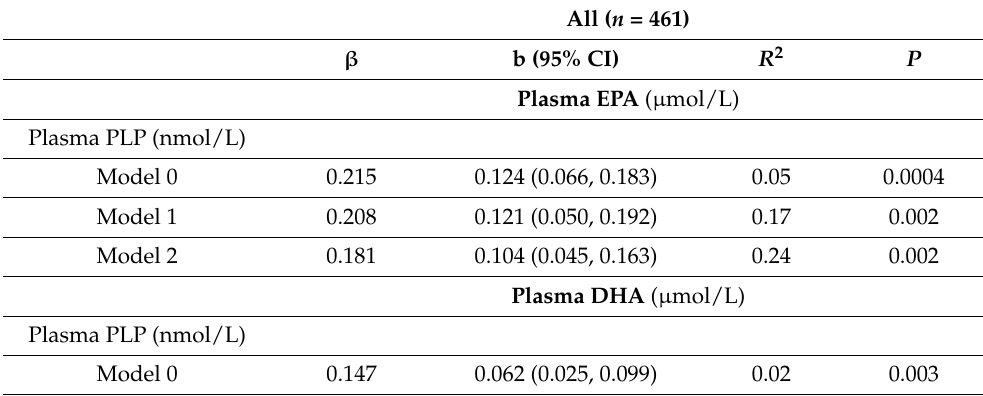
Table 4. Linear regression models: Associations of plasma PLP concentration with plasma PUFA concentrations and ratios among US adults aged ≥ 60 years, NHANES